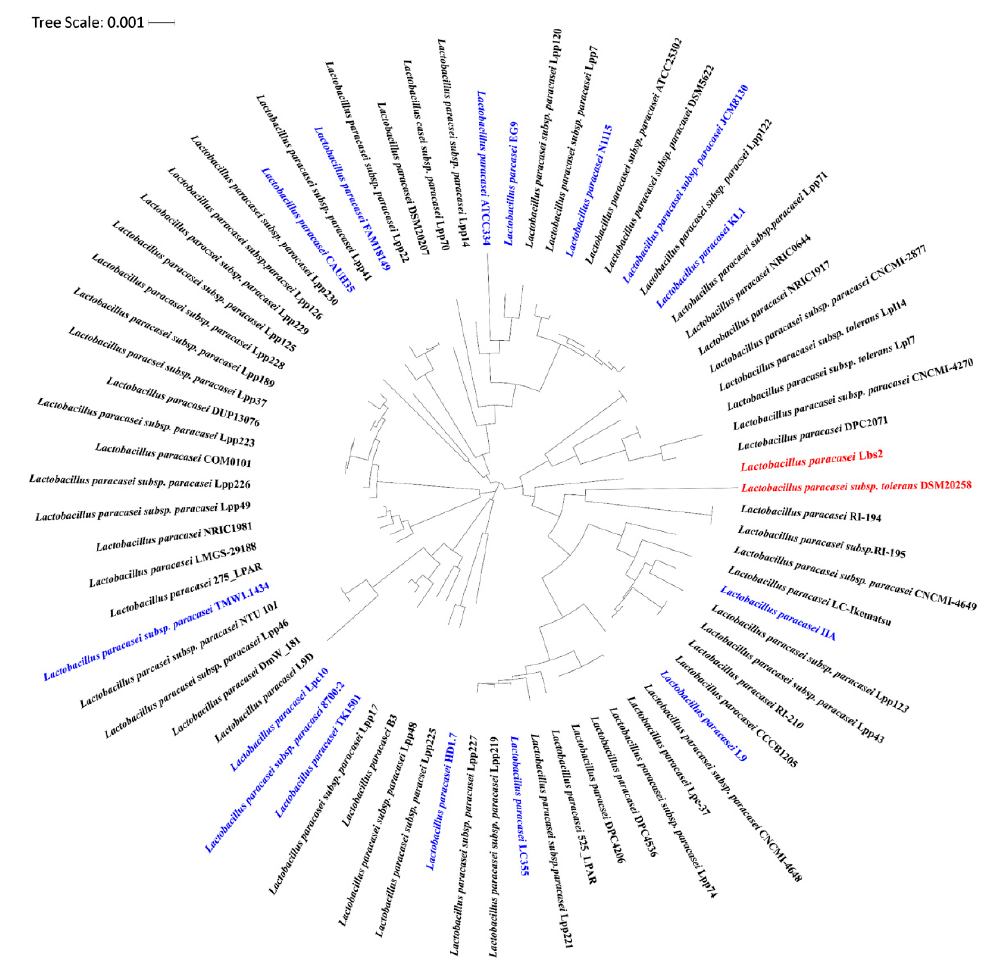
Figure 5. Whole genome phylogenetic tree of L. paracasei strains was inferred using the maximum likelihood method. The tree was built on the basis of the core-genome and it is presented as a cladogram. Complete genomes are marked as blue, while the genome of interest and its closest one are marked as red.